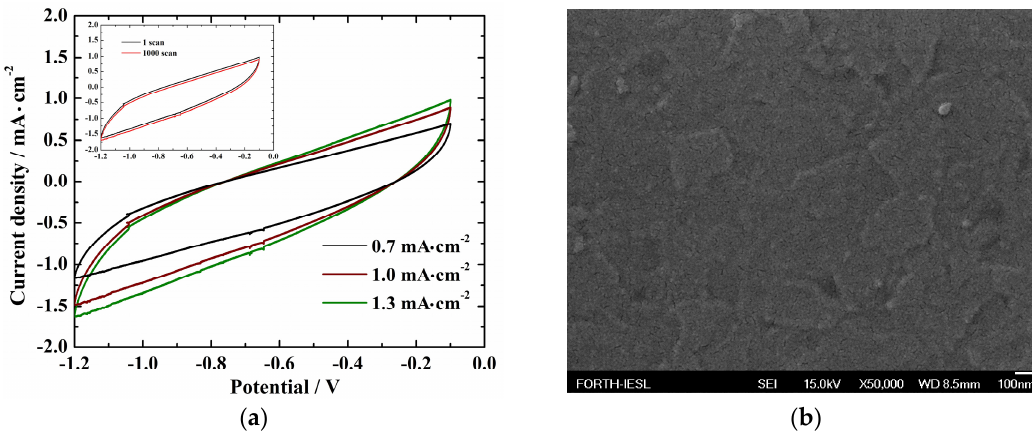
Figure 5. Cyclic voltammograms of electrodeposited V 2 O 5 at room temperature for current densities of 0.7, 1.0, 1.3 mA ∙ cm − 2 at a constant electrolyte concentration of 0.5 M (cyclic voltammograms of V 2 O 5 at current density of 1.3 mA cm − 2 for the 1st and the 1000th scan as inset) ( a ). FE ‐ SEM image of the electrodeposited V 2 O 5 for a current density of 1.3 mA ∙ cm − 2 after 1000 scans ( b ).